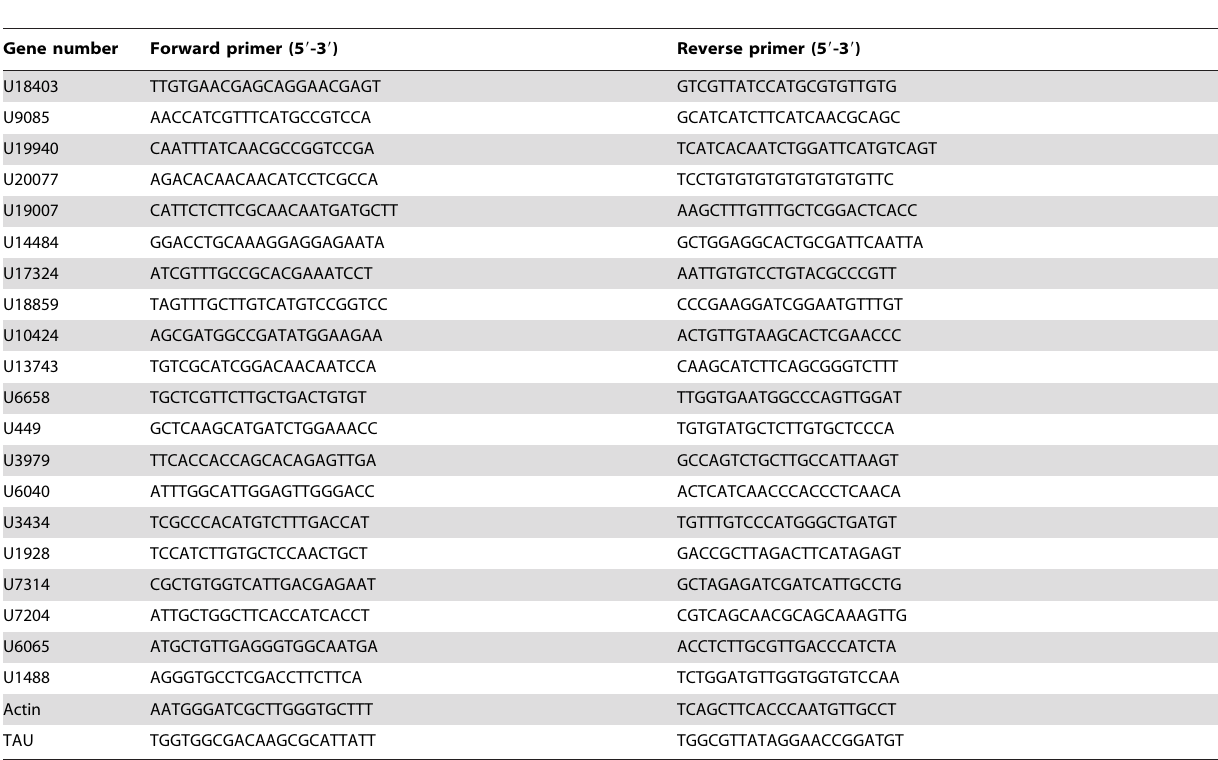
Table 1 . Primers used in Real-time RT-PCR.